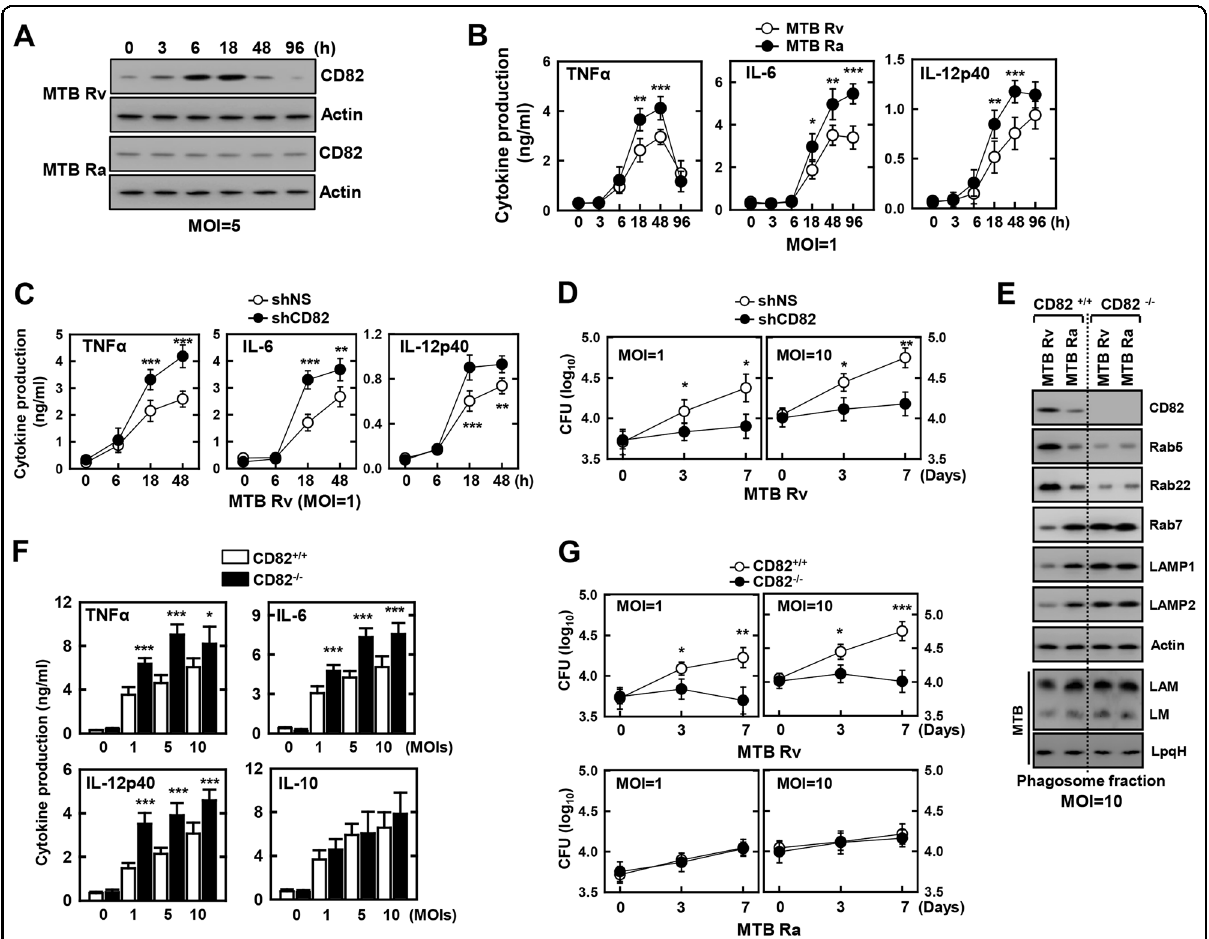
Fig. 2 The effects of CD82 on cytokine production and bacterial survival in macrophages. BMDMs were infected with MTB Rv or MTB Ra for the indicated times, followed by a immunoblotting (IB) with α CD82 and α Actin, or b culture supernatants were harvested and analyzed for cytokine ELISA for TNF α , IL-6, and IL-12p40. BMDMs were transduced with lentivirus-shRNA-NS or lentivirus-shRNA-CD82 for 2 days ( c , d ) or BMDMs from CD82 + / + and CD82 − / − ( f , g ) were with MTB Rv or MTB Ra for the indicated times, followed by intracellular survival of MTB assessed by CFU assay ( c , f ), or culture supernatants were harvested at 18 h and analyzed for cytokine ELISA for TNF α , IL-6, and IL-12p40 ( d , g ). e BMDMs from CD82 + / + and CD82 − / − were infected with MTB Rv or MTB Ra for 6 h. Mycobacteria-containing phagosome fractions were subsequently puri fi ed by sucrose-step- gradient ultra-centrifugation, followed by IB to detect α CD82, α Rab5, α Rab22, α Rab7, α LAMP1, α LAMP2, and α Actin. The polyclonal MTB Ab and LpqH Ab detect the lipoglycans (LAM and LM) and lipoproteins (LpqH), respectively. The data are representative of four independent experiments with similar results ( a , e ). Data shown are the means ± SD of six experiments ( b – d , f , g ). Signi fi cant differences (* P < 0.05; ** P < 0.01; *** P < 0.001) compared with shRNA-NS or CD82 + / + (Student ’ s t- test with Bonferroni adjustment). CFU colony-forming